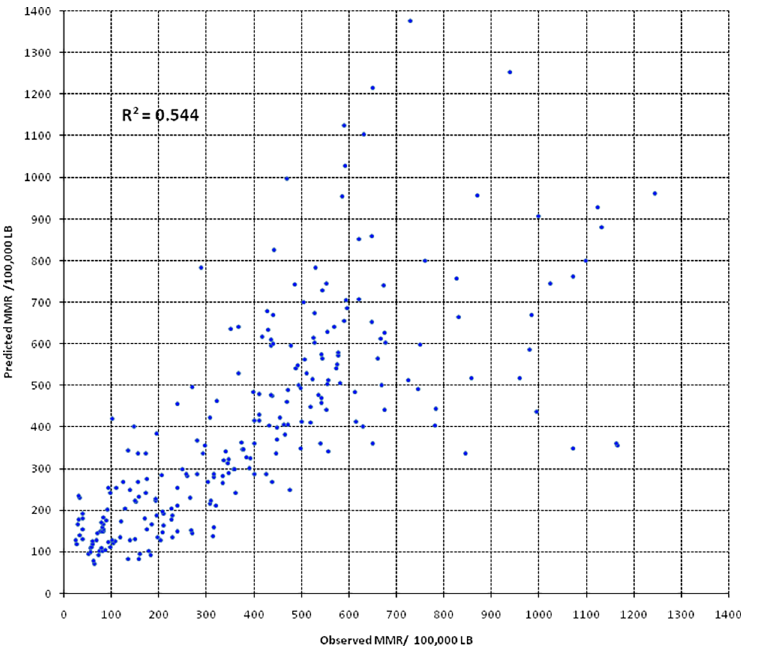
Fig 3. Relationship between observed and predicted values of MMR.